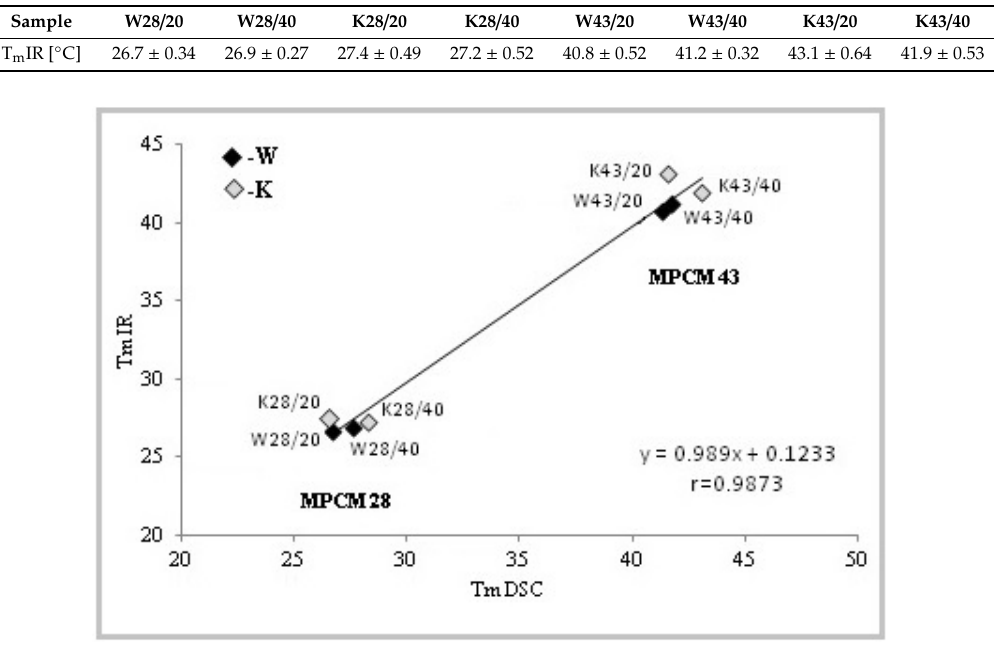
Table 2. Melting temperatures ( T m IR ) for woven and knitted fabric determined with infrared thermography.